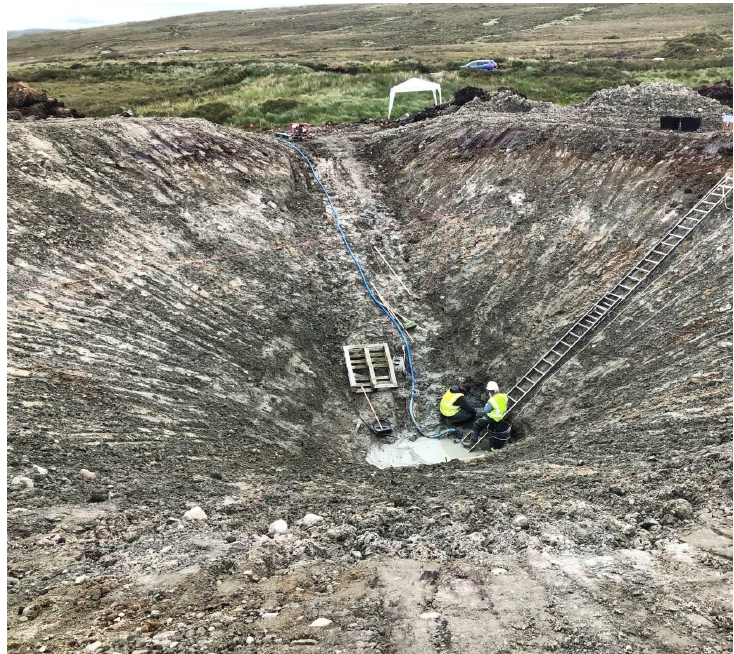
Figure A2. Excavation in 2019 to depth of 5.7 m and showing access ramp, submersible water pump and hose, and exit ladder. Examining the bottom and recovering rock fragments had to be done by feel at this stage.